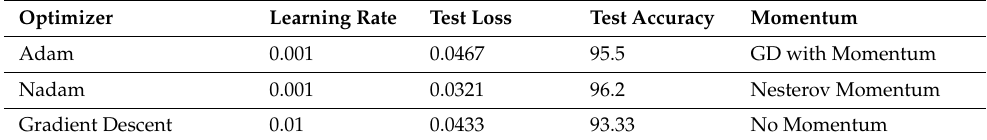
Table 6. Comparison of Different